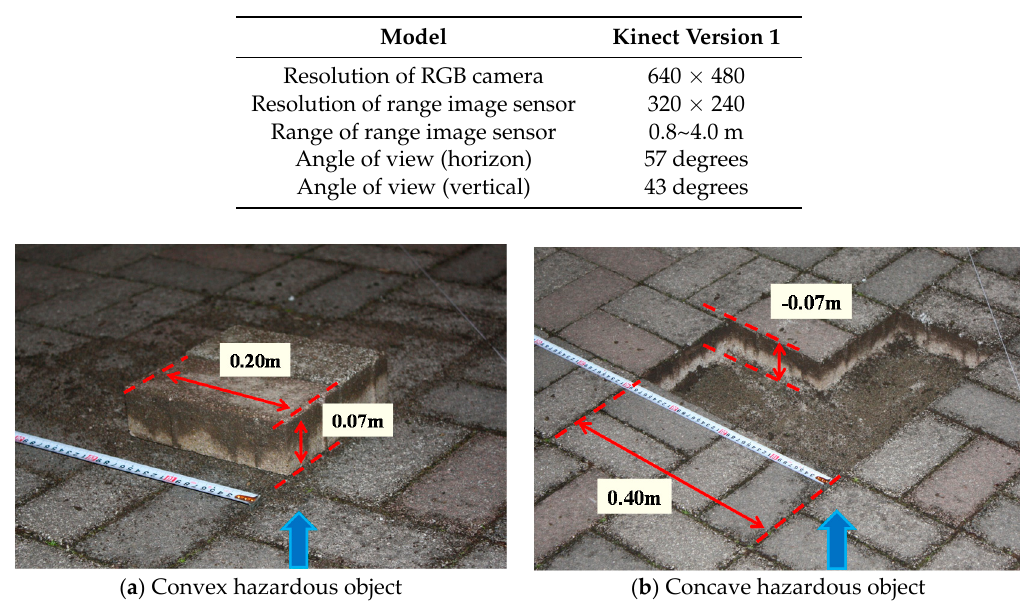
Figure 7. Static hazardous objects in experiments.